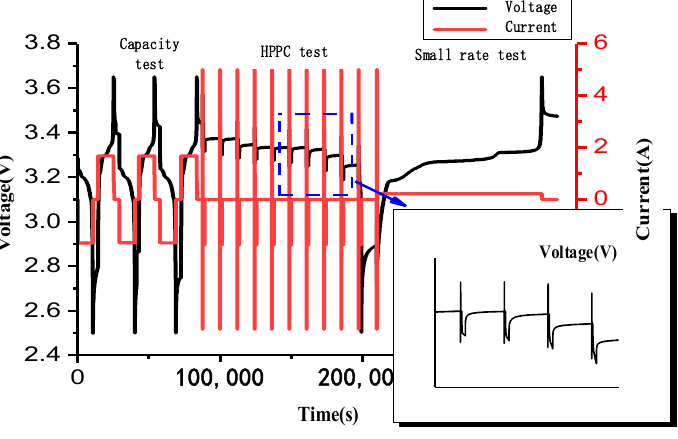
Figure 3. Voltage–current curve during the basic performance tests.